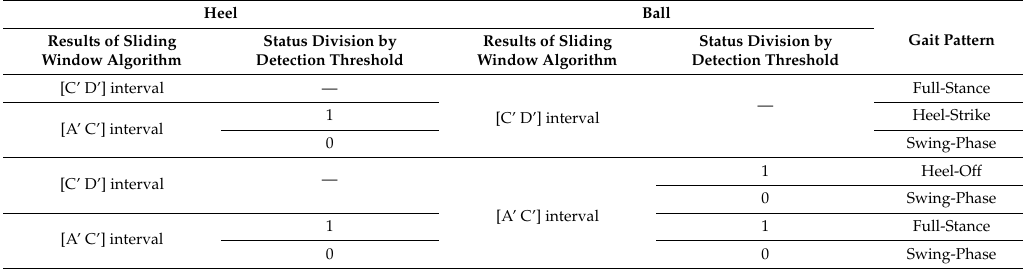
Figure 7. Using different P F gains for threshold computation. The line marked in blue is the GCFs detected to be in unstable area. The lines marked in red and green are the computed threshold using two different P F values. ( a ) The original signal analysis, ( b ) The exaggerating signal analysis for better demonstration. Table 1. Rule of gait pattern detection.